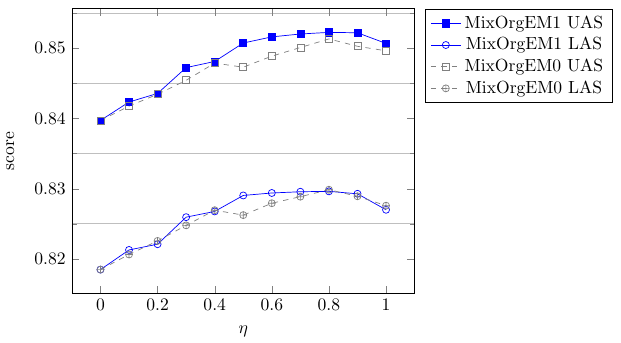
Figure 6. The fusion parsing accuracy with the SSGNS model under different η